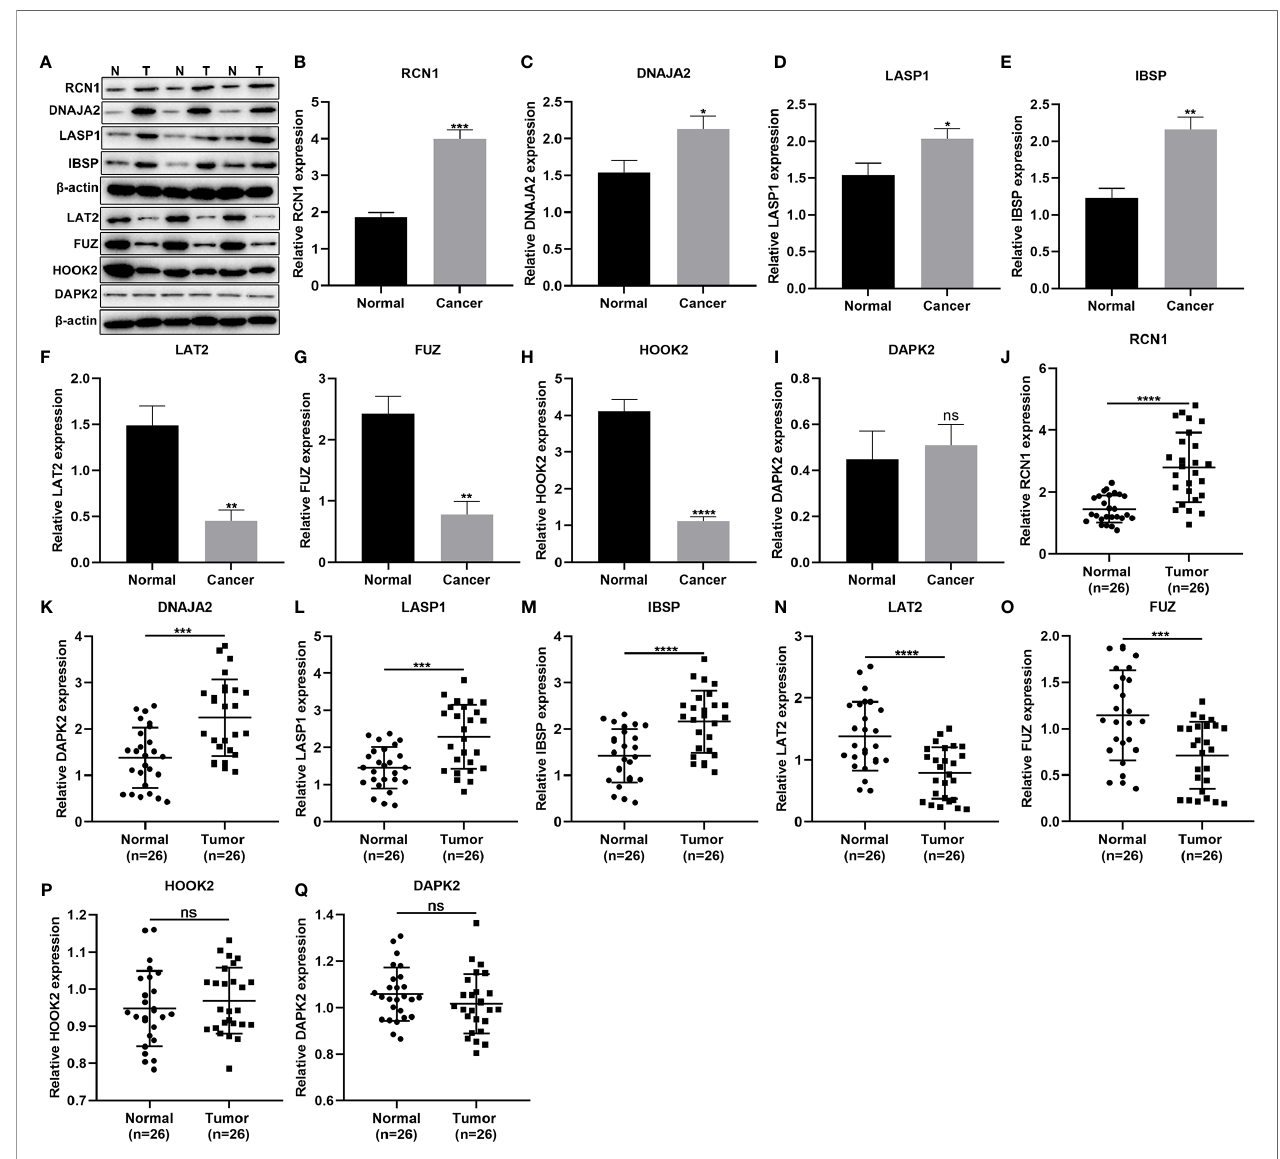
FIGURE 7 | Validation of the genes in the prognostic signature. (A – I) Western blot for detection of the protein expression of (B) RCN1, (C) DNAJA2, (D) LASP1, (E) IBSP, (F) LAT2, (G) FUZ, (H) HOOK2, and (I) DAPK2 in laryngeal cancer and normal tissues. (J – Q) RT-qPCR for detecting the mRNA expression of (J) RCN1, (K) DNAJA2, (L) LASP1, (M) IBSP, (N) LAT2, (O) FUZ, (P) HOOK2, and (Q) DAPK2 in laryngeal cancer and normal tissues. Ns, not signi fi cant; *P < 0.05; **p < 0.01; ***p < 0.001; ****p <